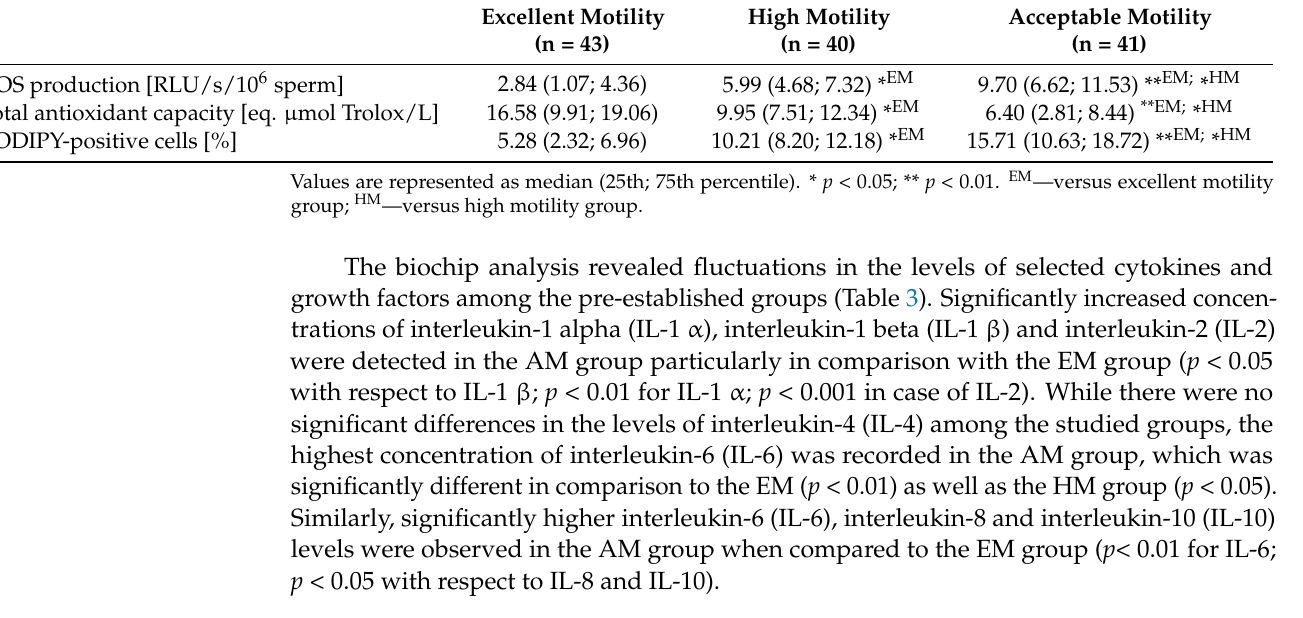
Table 3. Immune profile of semen collected from the studied